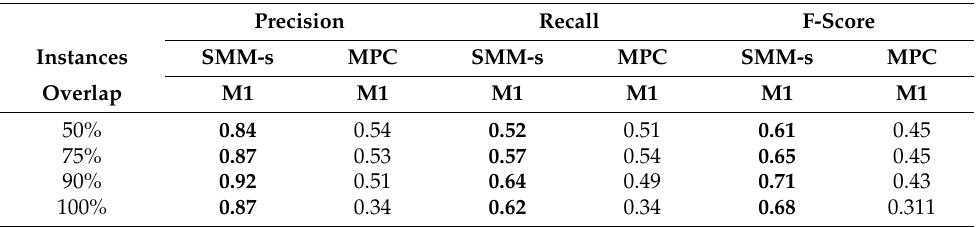
Table 3. Precision, recall and F-scores for series with one motif (M1) from MoCap, for varying target overlaps (average displacement 10%).